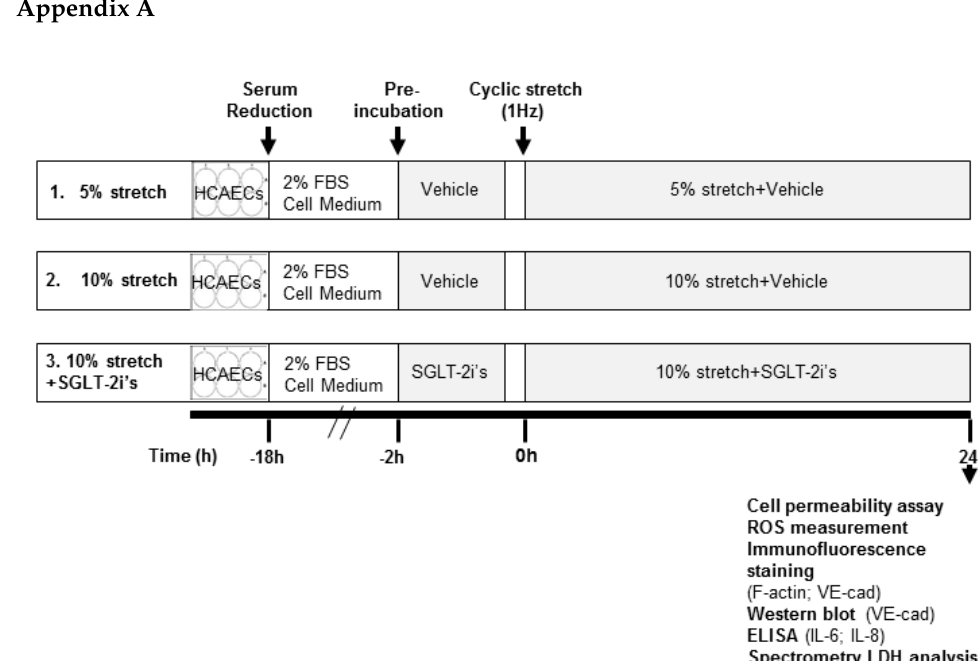
Figure A1. Study design Cells were starved for 18 h by serum reduction before a 2 h pre-incubation with either vehicle (0.06% DMSO) or one of the SGLT-2i’s (1 µ M EMPA, 1 µ M DAPA and 3 µ M CANA) under starving conditions, followed by stimulation with 10% stretch for 24 h. HCAECs exposed to 5% stretch with vehicle were considered as control. Cell permeability, ROS levels, cell morphology, VE-cadherin expression, interleukin production and LDH activity were measured after 24 h.